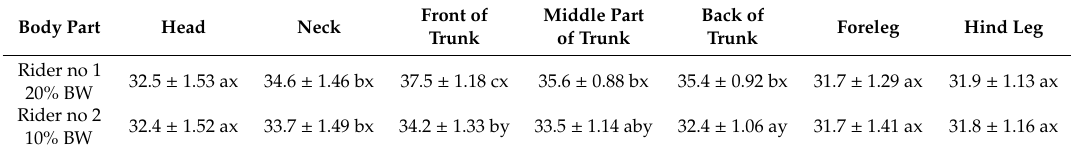
Table 6. Recovery phase average superficial temperatures ( ◦ C) of the studied body parts of the horse (Means ± SD).